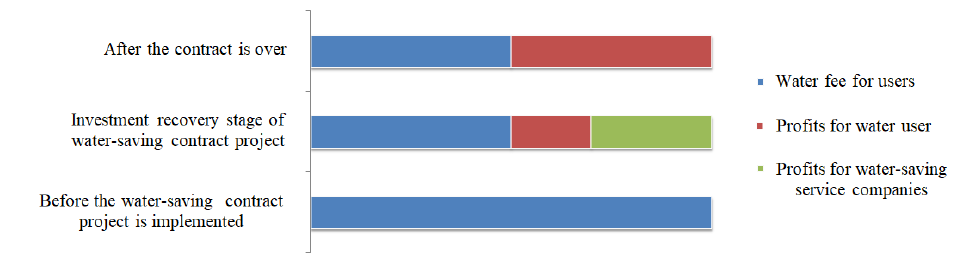
Figure 1. Profit model of water-saving contract projects.